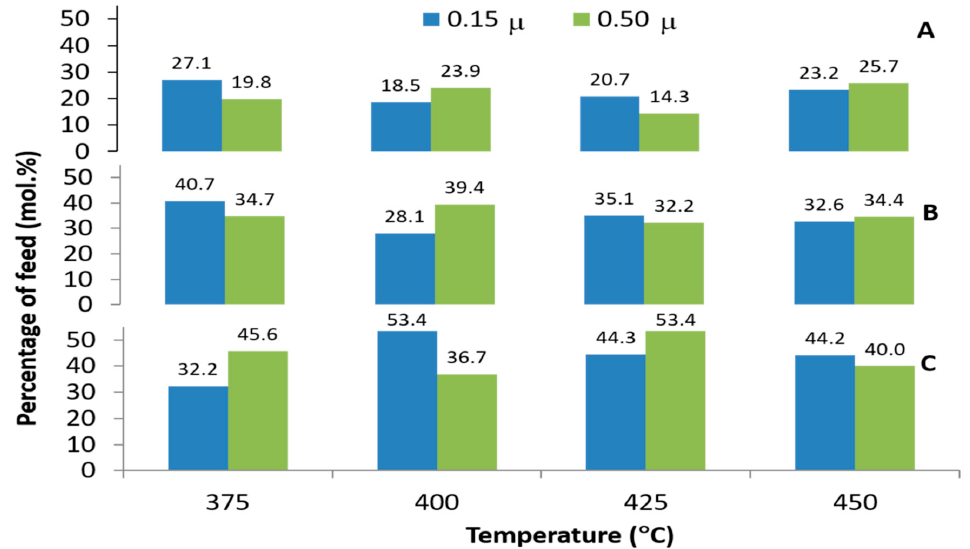
Figure 7. Gasoline (C 7 –C 11 )/( A ), Avture (C 12 –C 15 )/( B ) and diesel fraction (C 16 –C 19 ) / ( C ) product composition of mixed metal basic soap pyrolysis at different reaction temperatures and two different Ca/(Ca + Mg + Zn) metal ratios.